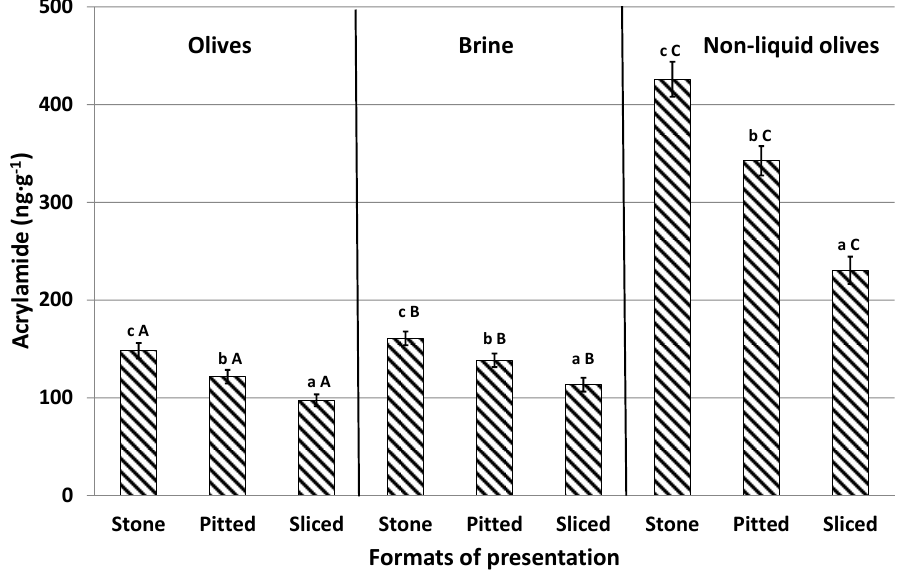
different presentation formats.